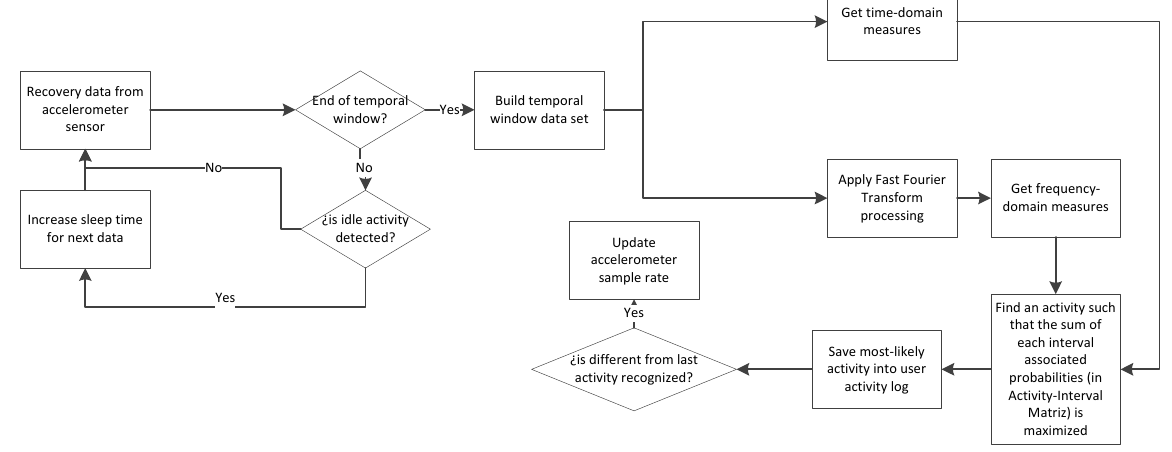
Figure 6. Flow diagram for the recognition